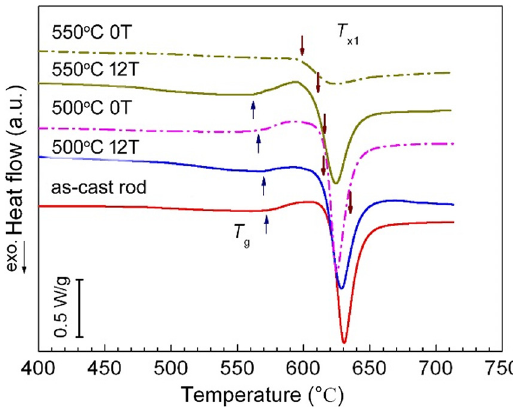
(Nb Zr ) B BMG after annealing 71 0.8 0.2 6 23